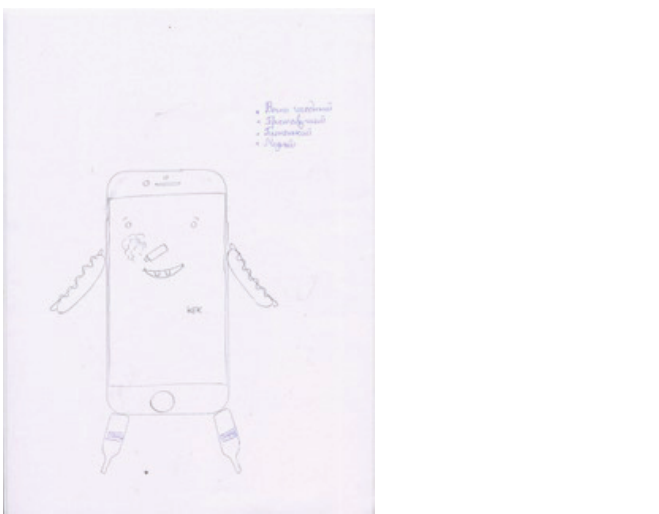
Figure 3: A student’s picture of a